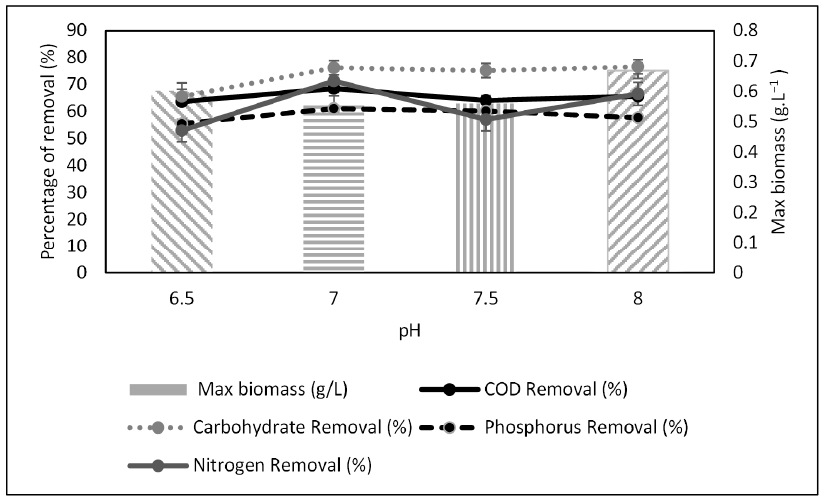
Figure 5. Physicochemical characteristics of treated raw leachate after batch cultivation. Nevertheless, although pH 7 exhibited the best values for physicochemical parame- ters, it recorded the lowest biomass of 0.560 g·L − 1 . In contrast, pH 8 had the highest bio- mass of 0.669 g·L − 1 . The composition of algal biomass is a vital indicator in assessing the potential of algae as a biofuel source [25]. pH affects the metabolic process of the algae, which includes its nutrient consumption. Unfavorable pH will restrict access to carbon,